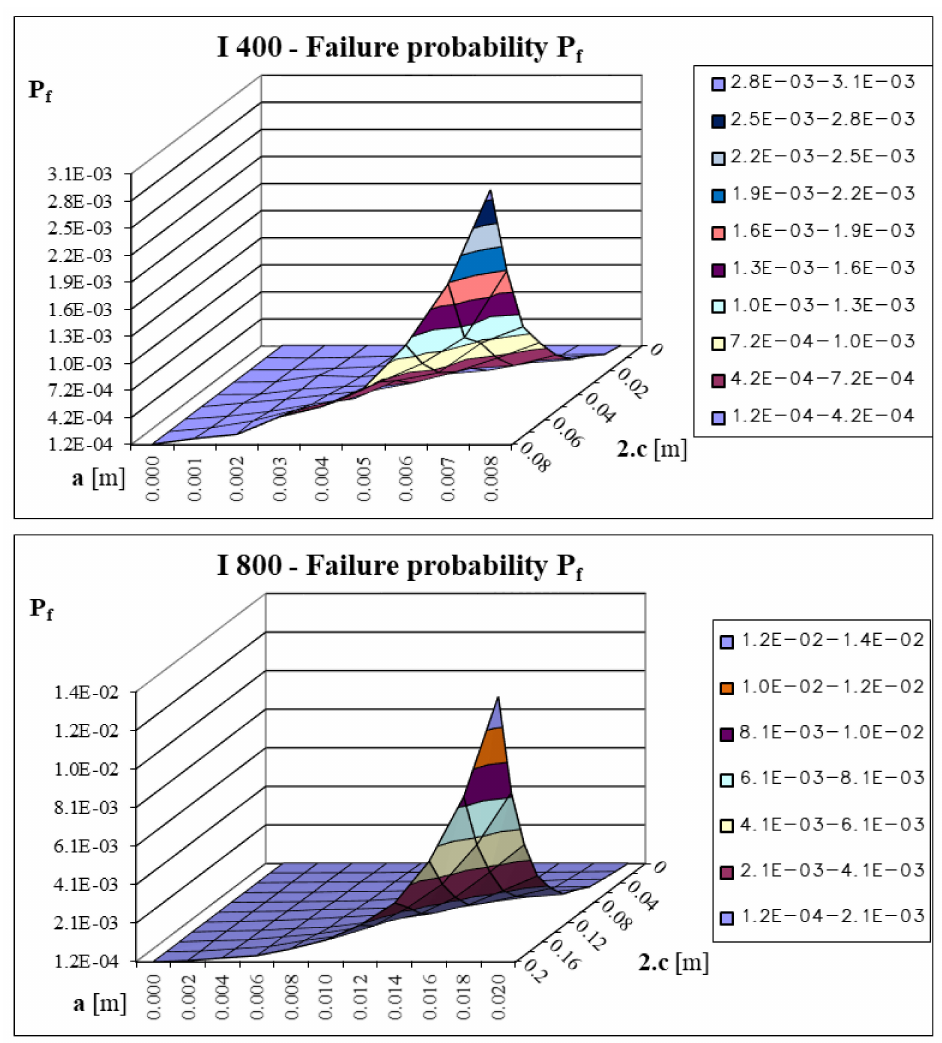
Figure 9. Influence of crack size on failure reliability P f